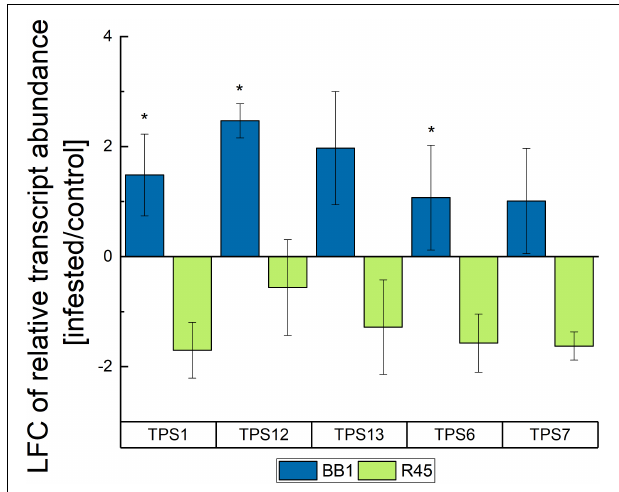
FIGURE 5 | Effects of larvae-induced root damage on the expression of terpene synthase genes in roots ( N = 6) of trees of two Q. robur populations (“BB1” and “R45”). Displayed are the means ± SE of the log2 values of the fold-changes (LFC) of relative gene expression between infested and control plants. Statistically significant differences between populations were calculated by Mann–Whitney U test for each TPS and are indicated by ∗ p < 0.05.